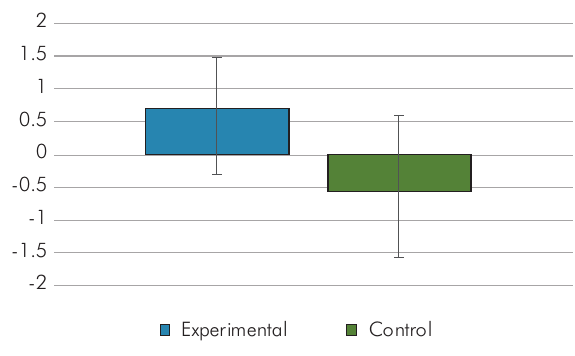
Figure 1. CGRP results for experimental and control teeth in placebo group; the total CGRP level change in the GCF before and after treatment was significantly higher for experimental teeth than control teeth (p < 0.05).